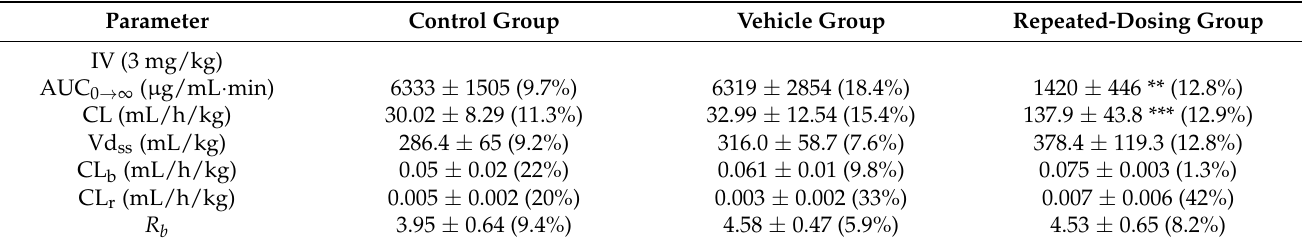
Figure 3. ( a ) Comparison of the total (light gray, n = 6), biliary (dark gray, n = 3), and urinary (black, n = 3) SCR430 clearance after IV SCR430 bolus administration (3 mpk) in the control, vehicle, and repeated-dosing groups. The biliary clearance (CL b ) ( b ) and urinary clearance (CL r ) ( c ) were also compared. A one-way ANOVA statistical analysis was used for the statistical analysis, followed by a Turkey’s post-hoc test, where appropriate. The stars indicate statistical significances, ** p < 0.01.